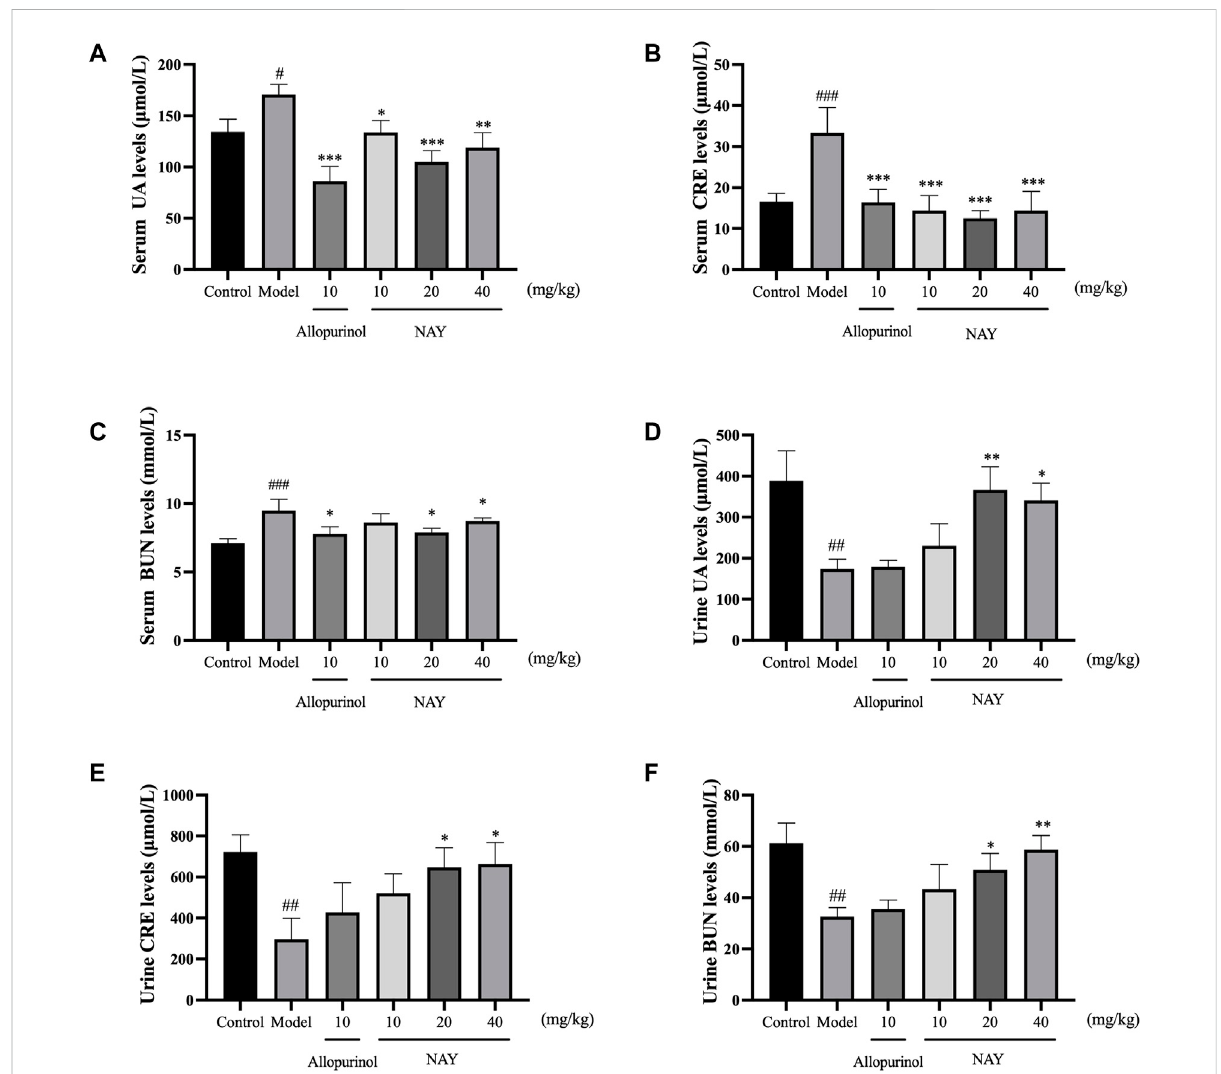
FIGURE 5 EffectsofNAYonthelevelsofserumUA (A) ,serumCRE (B) ,serumBUN (C) ,urineUA (D) ,urineCRE (E) ,andurineBUN (F) inhyperuricemiamice. (Data were expressed as mean ± S.E.M.; n = 8 (serum) or n = 5 (urine). Compared with the control group, # p < 0.05, ## p < 0.01, and ### p < 0.001. Compared with the model group, * p < 0.05, ** p < 0.01, and *** p <